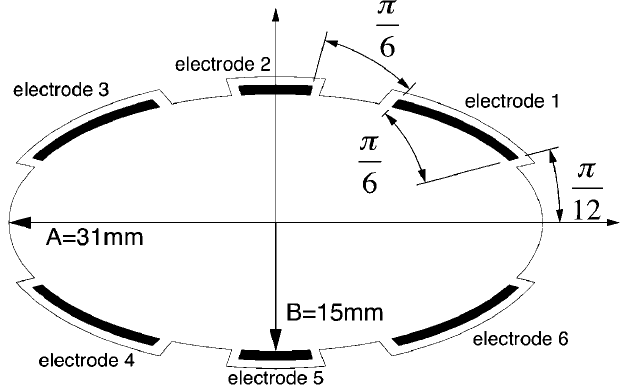
FIG. 12. Configuration of a specific six-electrode BPM with elliptical cross